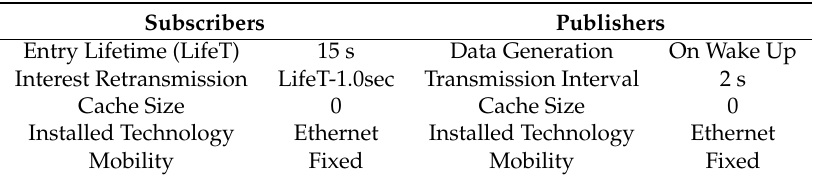
Table 1. ICN node simulation